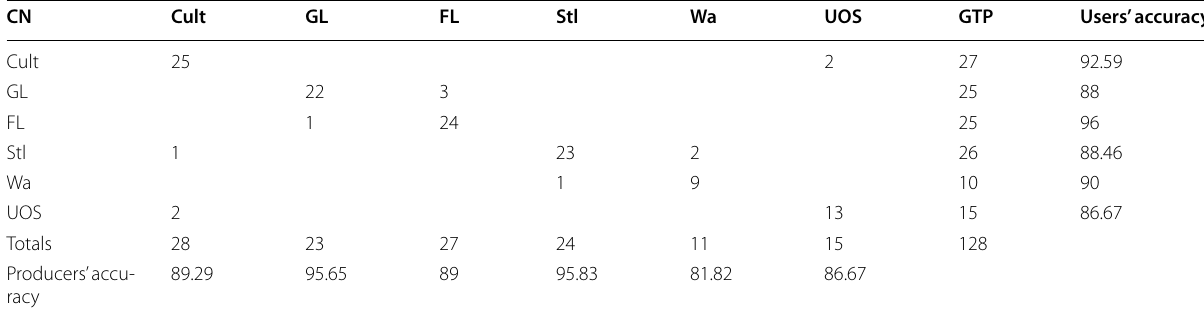
Table 5 Accuracy assessment report of UGS assessment of DMC